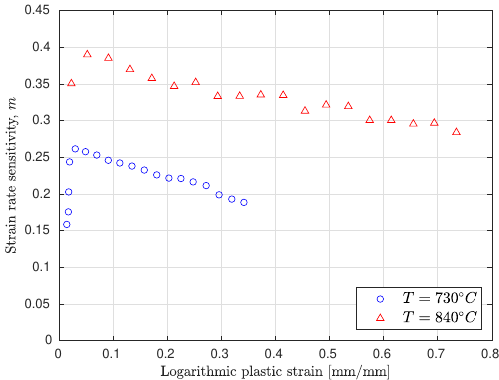
Figure 11. Dependence on the strain rate sensitivity ( m value) on strain at T = 730 ◦ C and T = 840 ◦